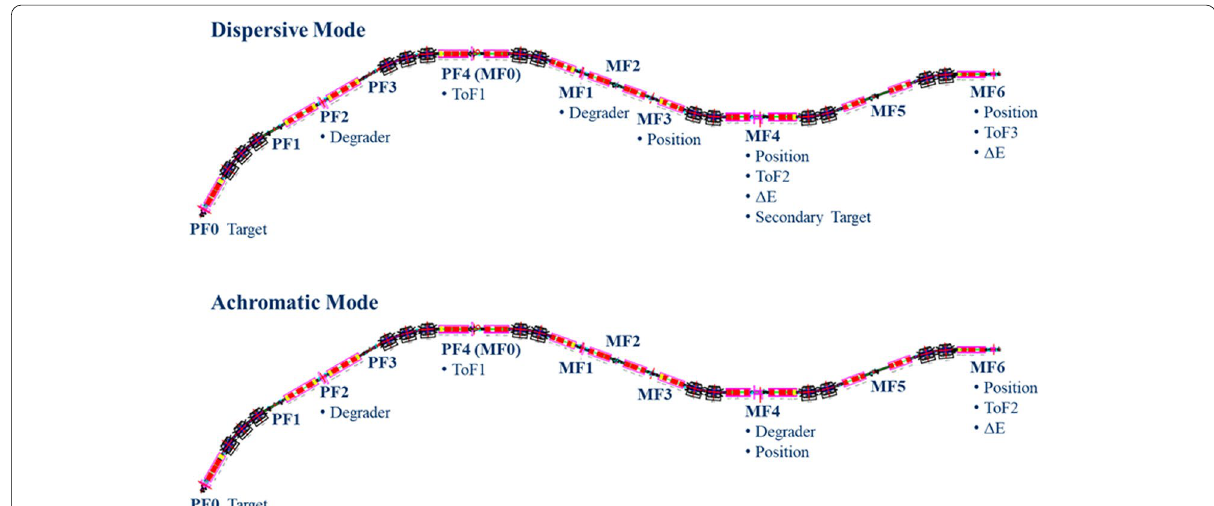
Fig. 9 Schematic views of the experimental setups for the dispersive mode (upper) and the achromatic mode (lower). The foci are indicated. The main separator from MF0 to MF6 comprises superconducting dipole magnets in black and multipole magnets in